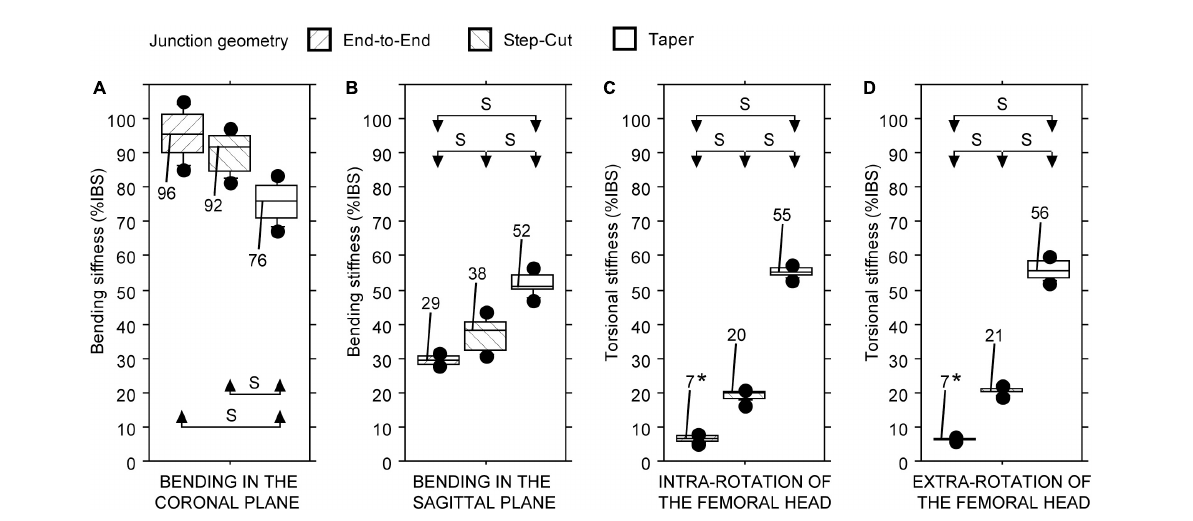
FIGURE4 Bending and torsional stiffness, expressed as a percentage of intact host bone stiffness (%IBS) determined for the intercalary reconstruction with bone plate fixation differing in junction geometry. (A) Bending stiffness in the coronal plane. (B) Bending stiffness in the sagittal plane. (C) Torsional stiffness in intra-rotation direction. (D) Torsional stiffness in extra-rotation direction (S = statistically significant difference; * = test limited to 14 Nm).